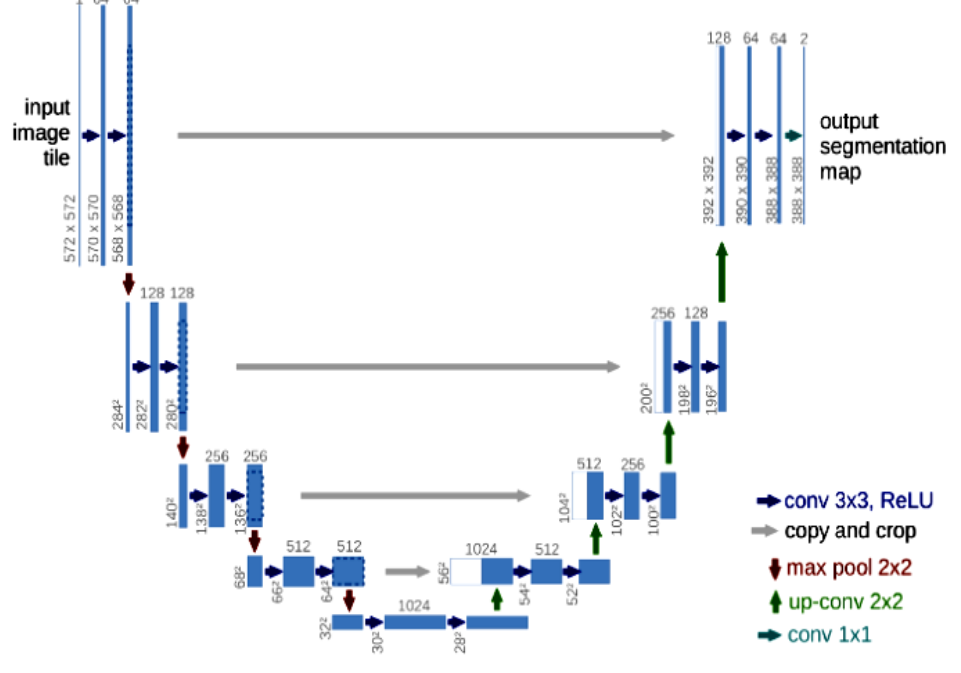
Figure 2. UNET model [16].